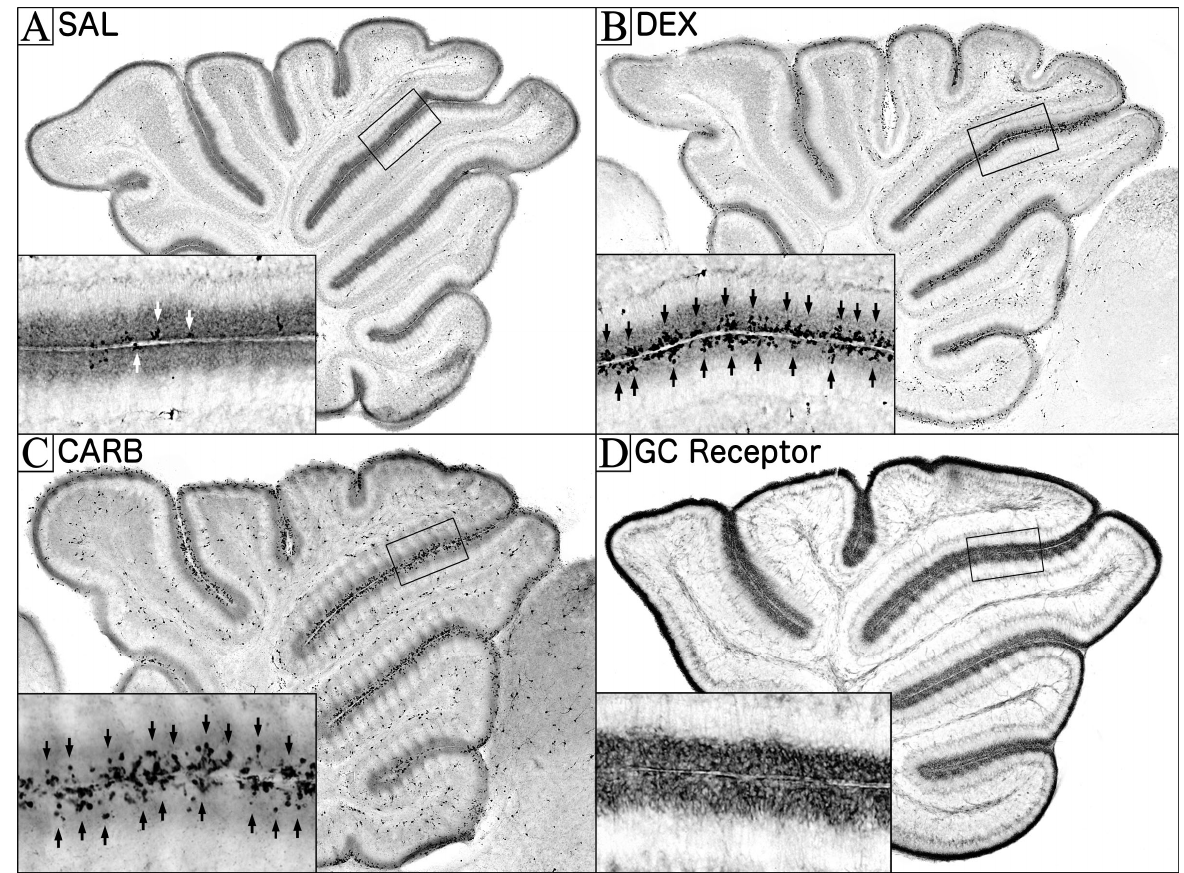
Figure 1. Glucocorticoid receptor stimulation in the neonatal rodent cerebellum. ( A – C ) Immunolabeling in the midsaggittal mouse cerebellum with the apoptotic marker activated caspase-3, six hours after saline (SAL), 3.0 mg/kg dexamethasone (DEX), or 100 mg/kg carbenoxolone (CARB). ( A ) SAL treated animals exhibited low amounts of physiological apoptotic death (white arrows), whereas ( B ) DEX treated animals exhibited dramatic increases in apoptosis (black arrows) throughout the EGL; ( D ) Simply, inhibiting HSD2 (an enzyme which metabolizes and protects against certain GCs) with 100 mg/kg carbenoxolone (CARB) rapidly increases NPC apoptosis in the EGL (black arrows). This suggests that when HSD2 is present, it is constantly preventing endogenous GC stimulation from producing EGL apoptosis. ( C ) Immunolabeling with the GC receptor antibody M20 reveals GC receptors are densely located in the EGL of the PND7 neonatal mouse. Insets reflect magnified views of boxed